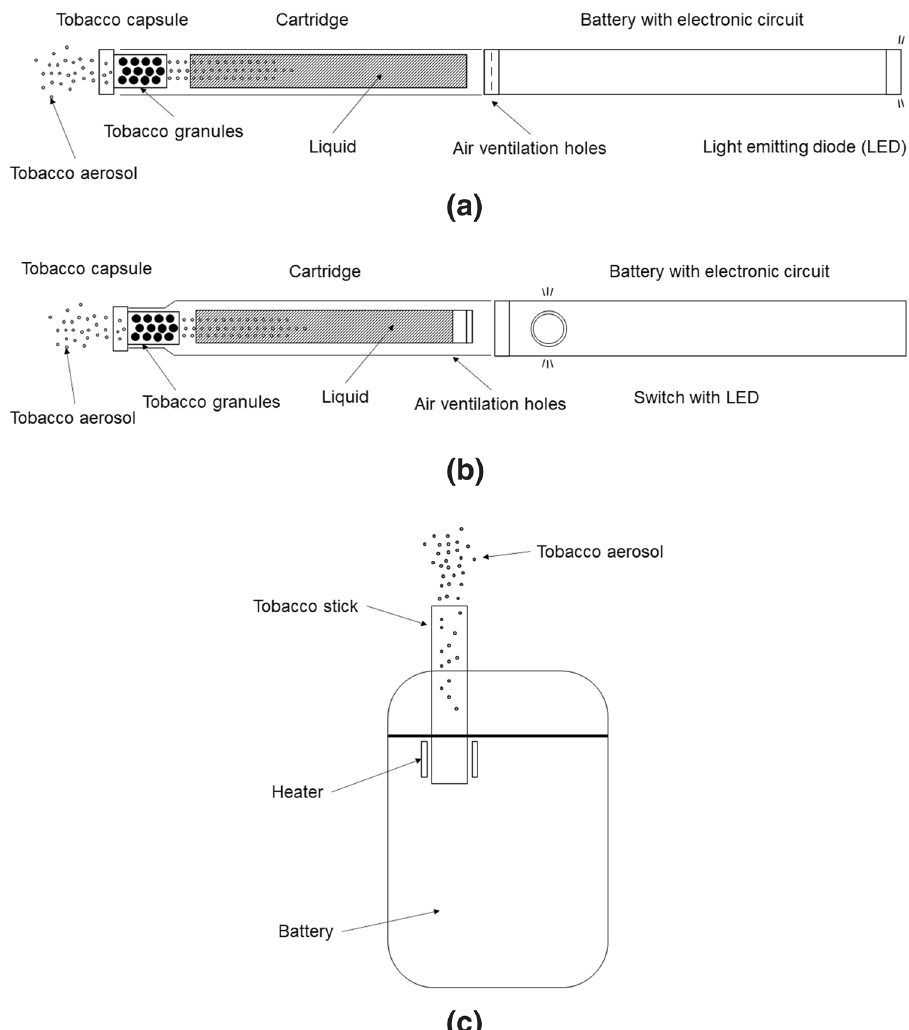
Fig. 1 Schematic of three types of heating tobacco system: a IT1.0a, b IT2.0a, and c